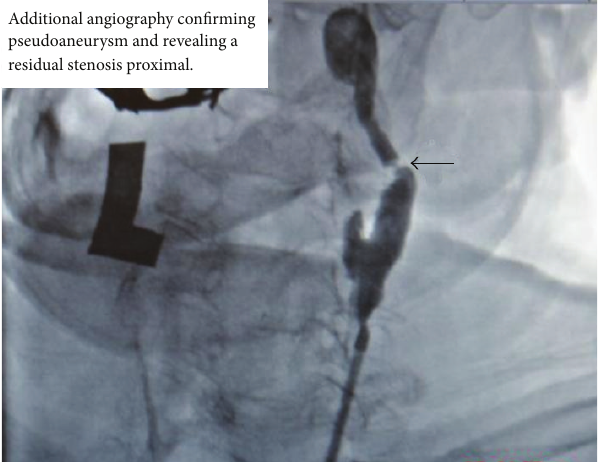
Figure 4: Postintervention angiography; pseudoaneurysm is suc- cessfully obliterated and residual stenosis has been